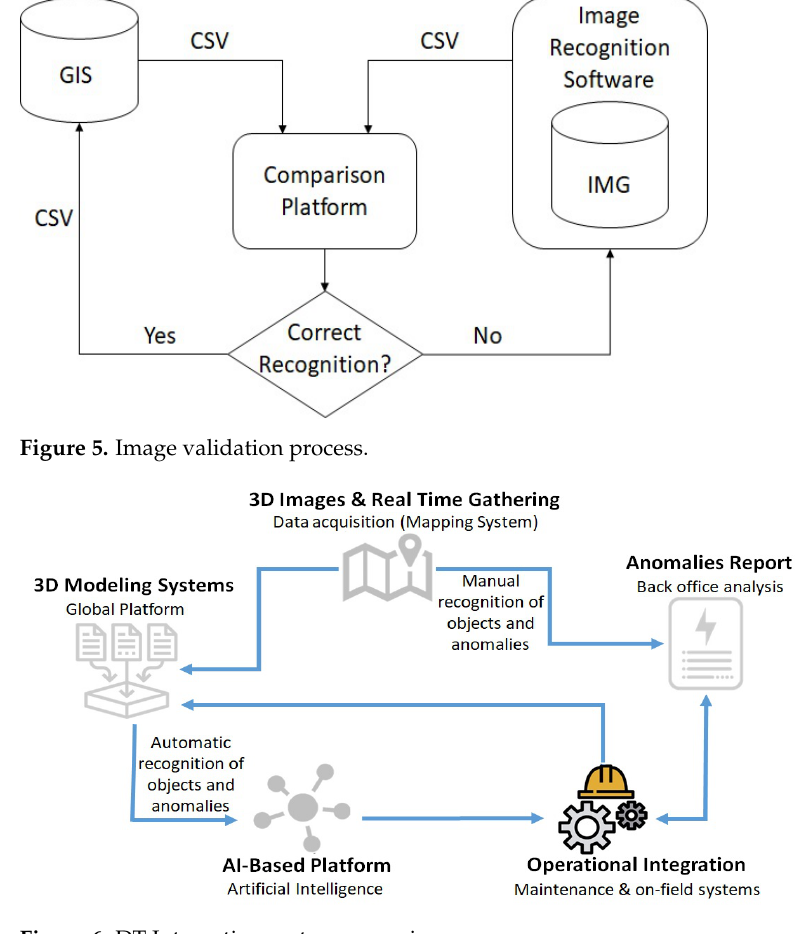
Figure 6. DT Integration systems overview.